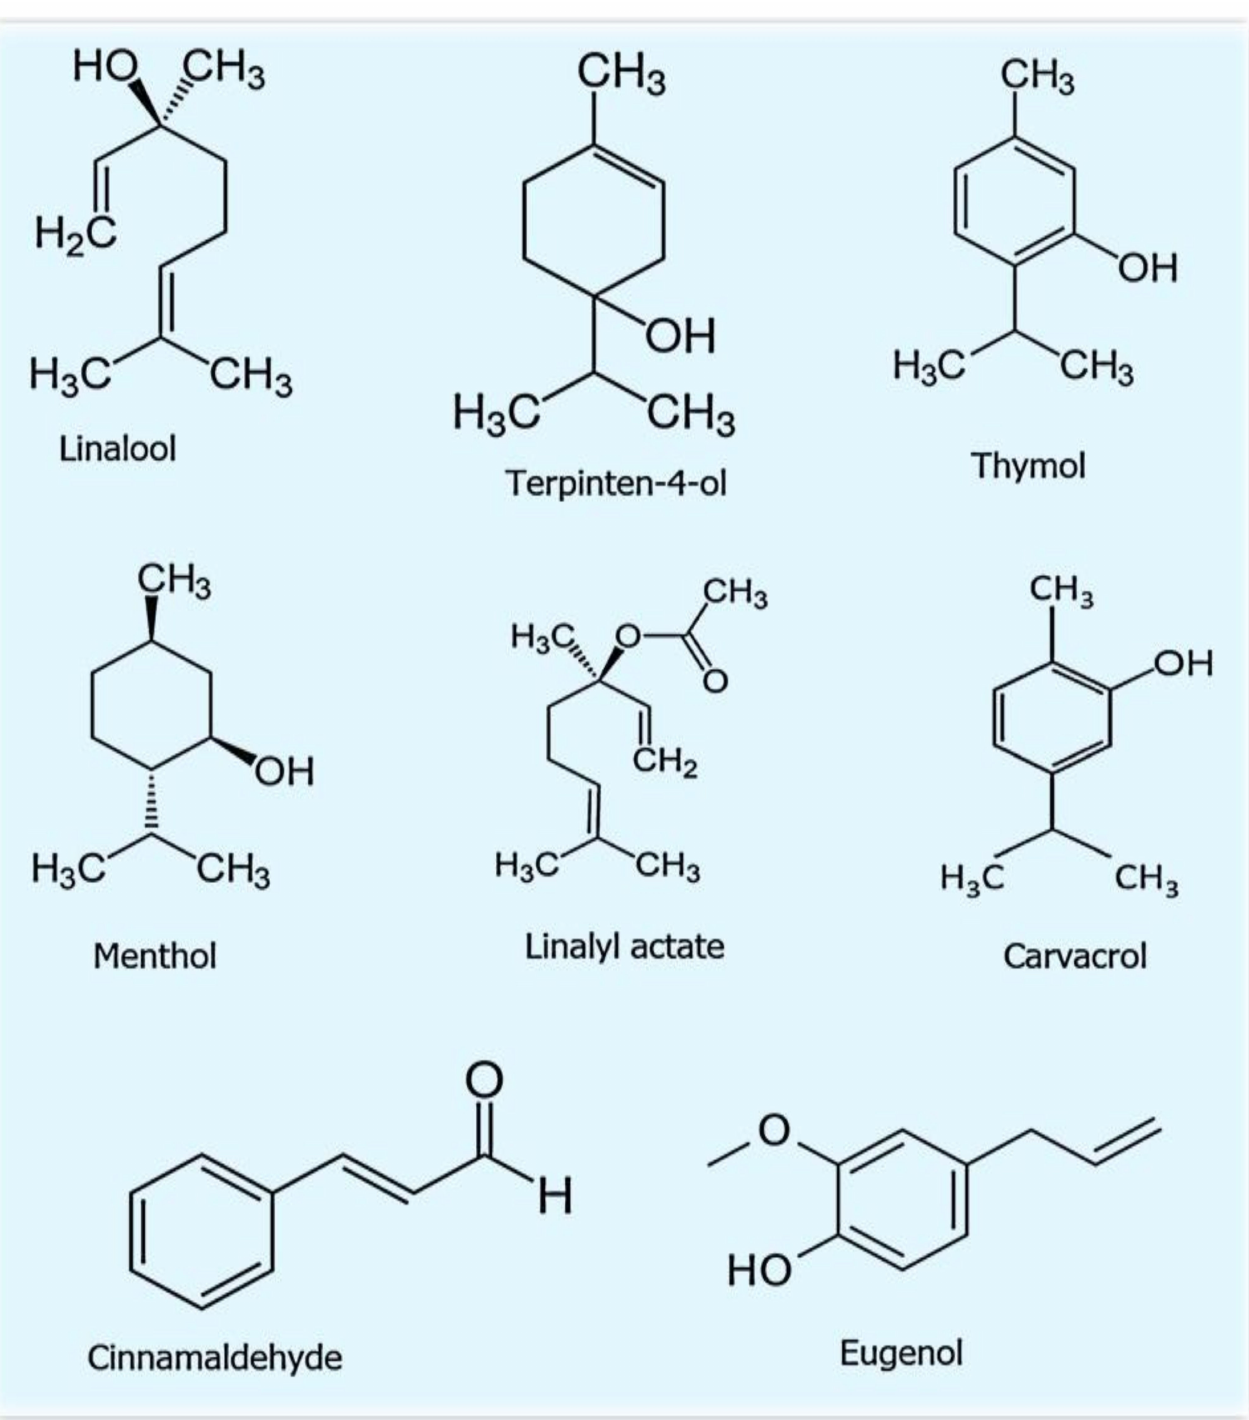
Figure 3. Structures of some of the important constituents of essential oils (reproduced from Wikipedia) via created common